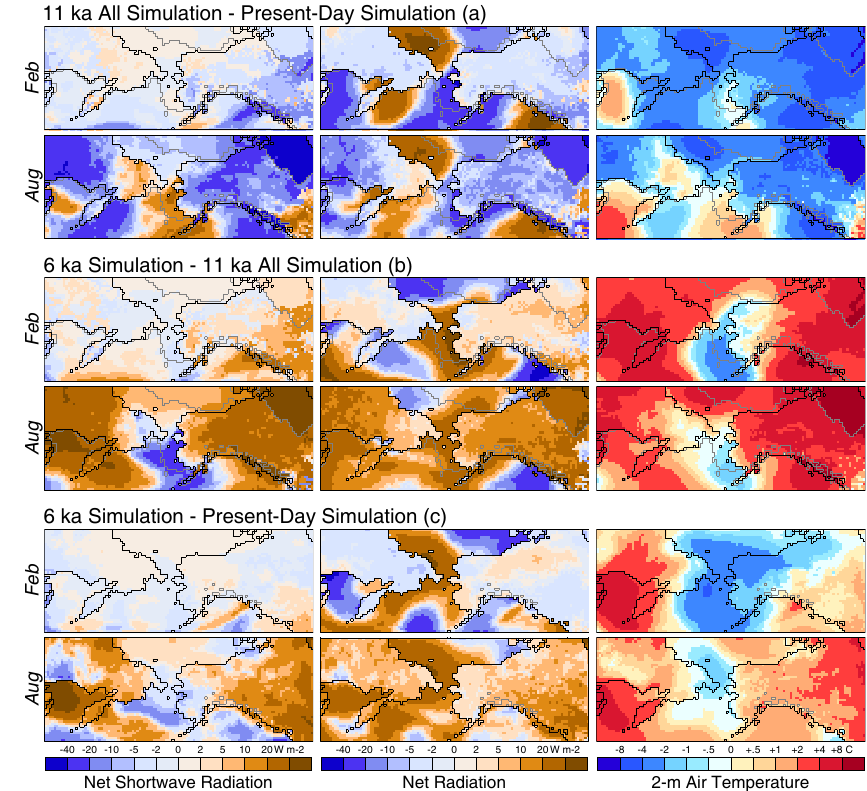
Figure 12. Net shortwave radiation (surface), net radiation and 2m air temperature differences for February and August. (a) 11ka All minus Present Day , illustrating the impact of 11ka insolation (relative to that at present); (b) 6ka minus 11ka All , illustrating the impact of changes in boundary conditions other than concurrent insolation between 11 and 6ka; (c) 6ka minus Present Day , illustrating the impact of 6ka insolation (relative to that at present). Ice-sheet and coastal outlines as in Fig.